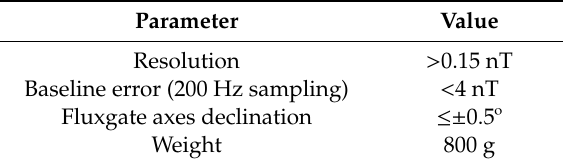
Table 4. Parameters of SenSys MagDrone R1 UAS-borne fluxgate magnetometer system [53].